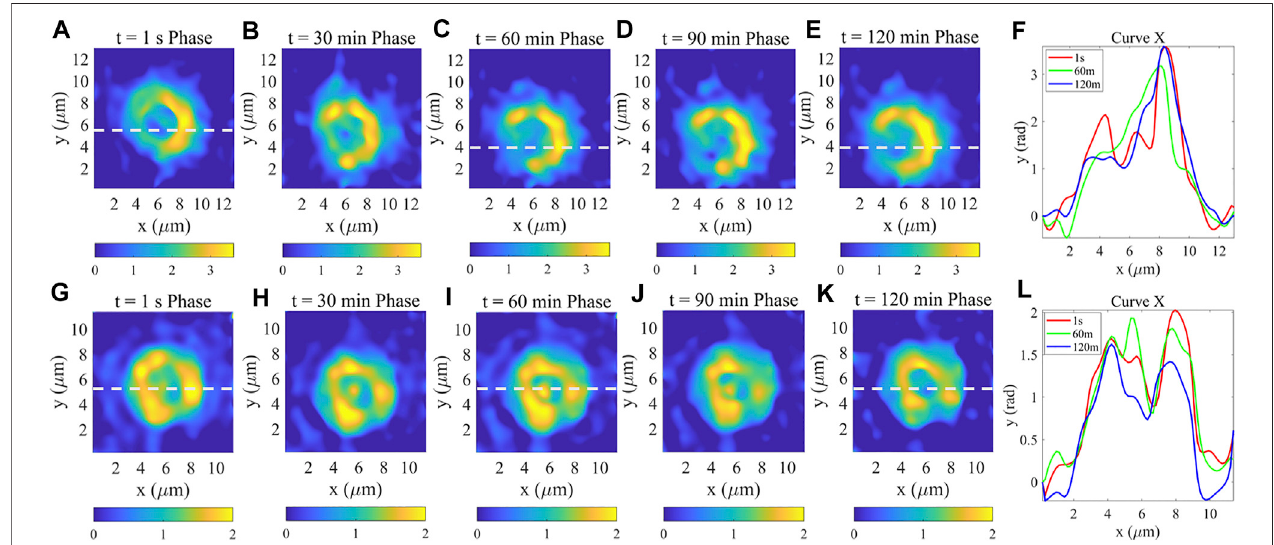
FIGURE 5 | (A) Phase Maximum variation of red blood cells without anticoagulant. (B) Phase Maximum variation of red blood cells with anticoagulant. σ : Standard deviation of the RBC Phase Maximum.